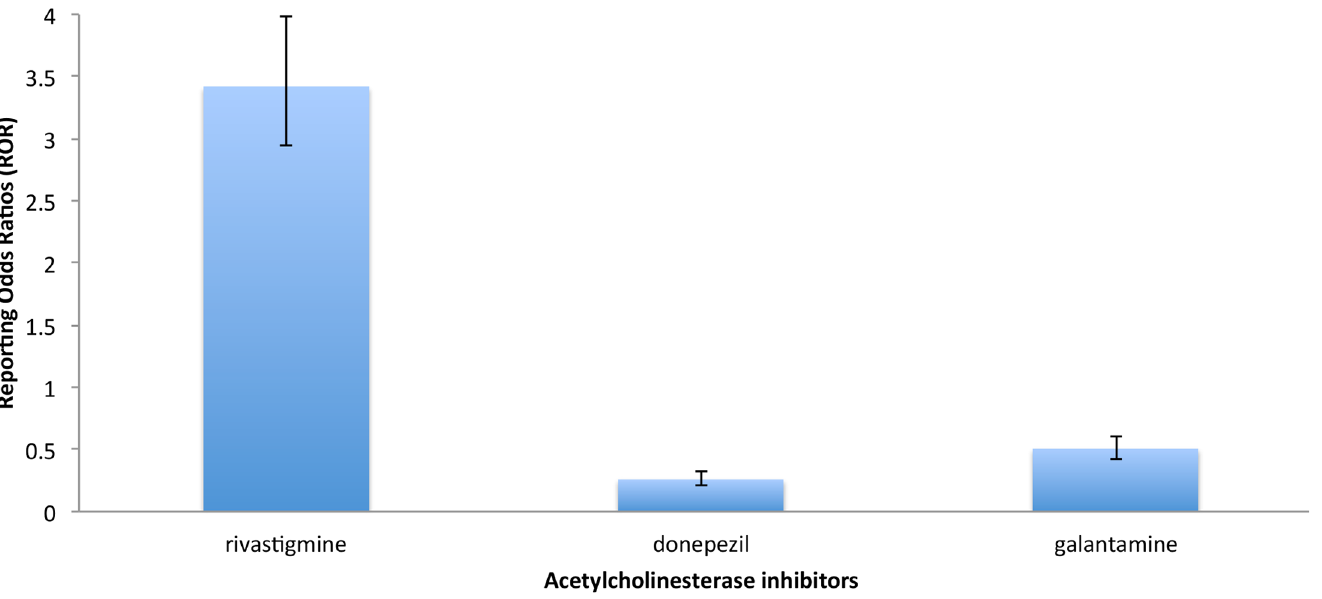
Fig 1. Rates of death for specific ChEI in the FAERS database. Reporting odds ratios comparing the rates of death for specific ChEI to the rates for the general ChEI drug